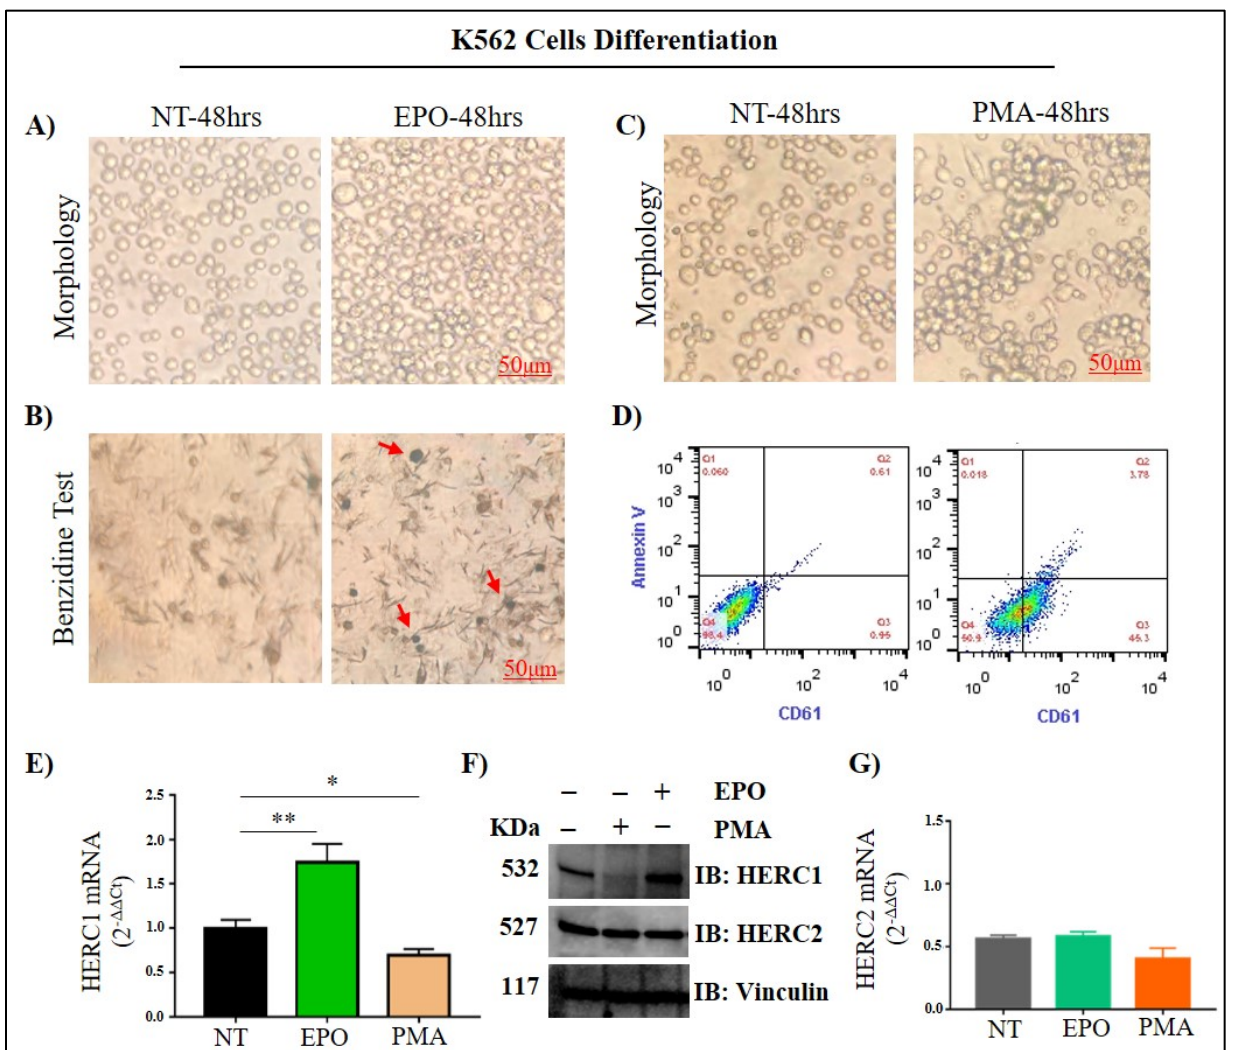
Figure 5. Leukemic cells’ differentiation towards the erythroid and megakaryocyte-like lineages antagonistically affect the HERC1 levels. Differentiation was performed by incubating Ph+ K562 myeloid leukemia cell lines with 250 nM phorbol 12 myristate 13-acetate (PMA) and 20 U/mL Erythropoietin (EPO). ( A ) Representative pictures of the morphology of uninduced control and differentiated cells; ( B ) K562 cells were harvested after 48 h with or without EPO induction and stained with benzidine. Benzidine-positive cells turned blue, indicated with red arrows. Untreated K562 cells served as a control. ( C , D ) Representative cell morphology images and flow cytometry analysis of PMA treated K562 cells. Prior flow cytometry cells were stained for megakaryocyte- specific cell surface marker CD61. ( E , F ) Expression changes in HERC1 gene at mRNA and protein level in non-treated, EPO, and PMA induced K562 cells. An increase in HERC1 protein and mRNA level was seen in EPO-treated K562 cells, while a decrease in HERC1 gene expression was observed in PMA treated cells. ( G ) Interestingly, there is not any change in HERC2 protein level in K562 differentiated cells. p ≤ 0.05 = *; p ≤ 0.01 =